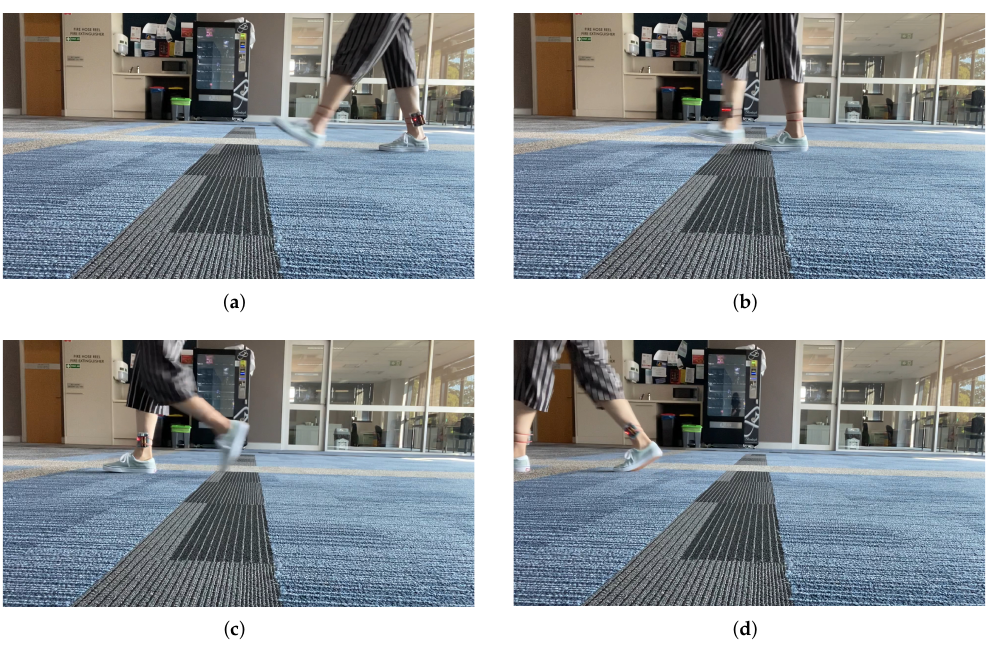
Figure 5. Feet positions at different time stamps of the indoor walking experiment. ( a ) t = 2.22 s ( PL OA = 46 dB); ( b ) t = 2.80 s ( PL OA = 46 dB); ( c ) t = 3.12 s ( PL OA = 50 dB); ( d ) t = 3.72 s ( PL OA = 50 dB).